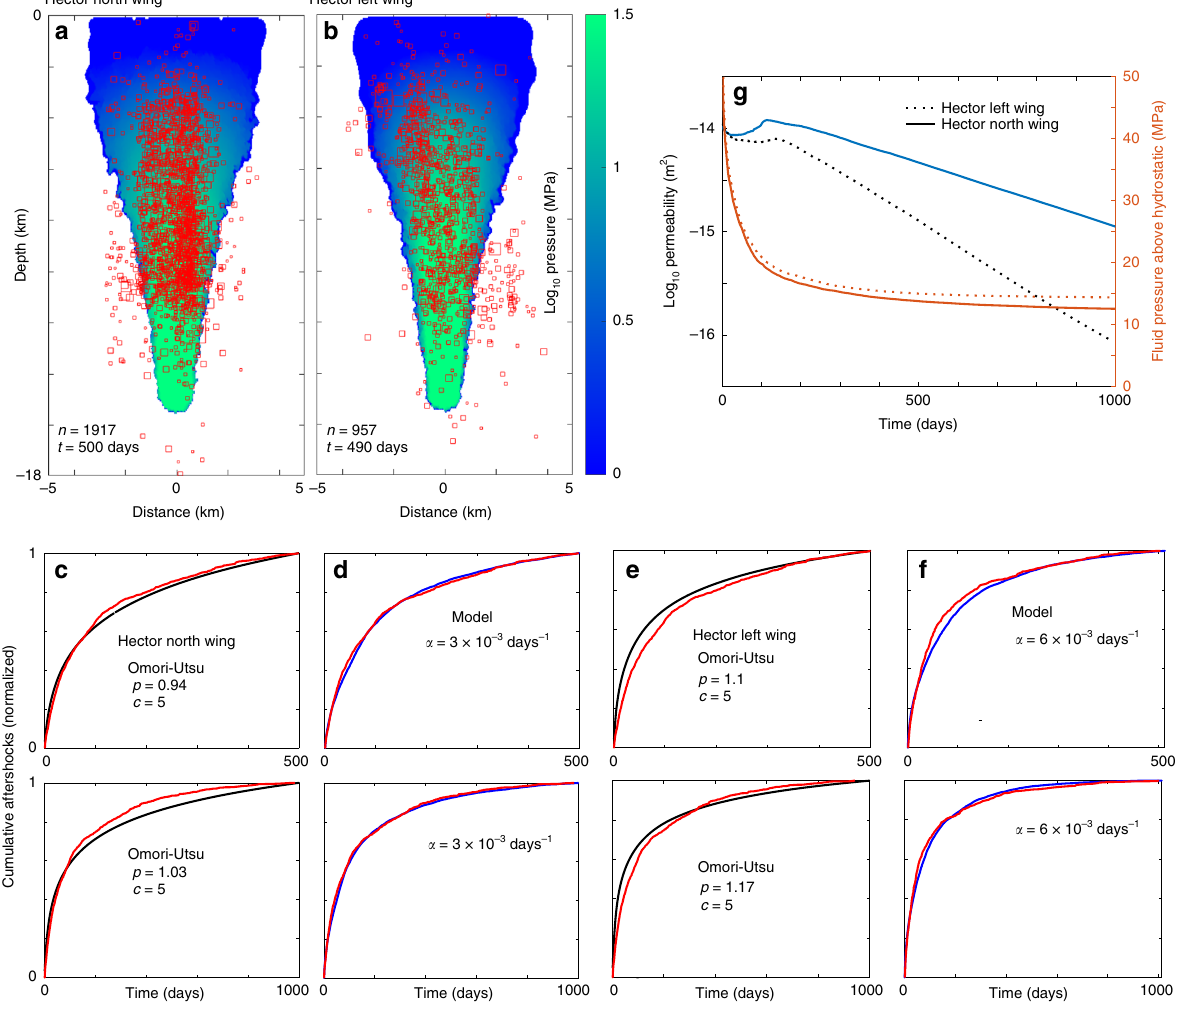
Fig. 4 Model results for Hector North Wing and Left Wing. Comparison of 1917 measured hypocenters and the computed fl uid pressure fi eld for ( a ) North Wing and ( b ) Left Wing (957 hypocenters). ( c ) comparison of data (red) and the Omori fi t (black) for two different time windows, and ( d ) same data (red) compared to model results (blue) for the same time windows for North Wing. ( e ) comparison of data (red) and the Omori fi t (black) for two different time windows, and ( f ) same data for Left Wing (red) compared to model results (blue) for the same time periods. ( g ) Average pressure and permeability time histories of the stimulated region showing Left Wing recovers permeability signi fi cantly faster than North Wing. Note the different p